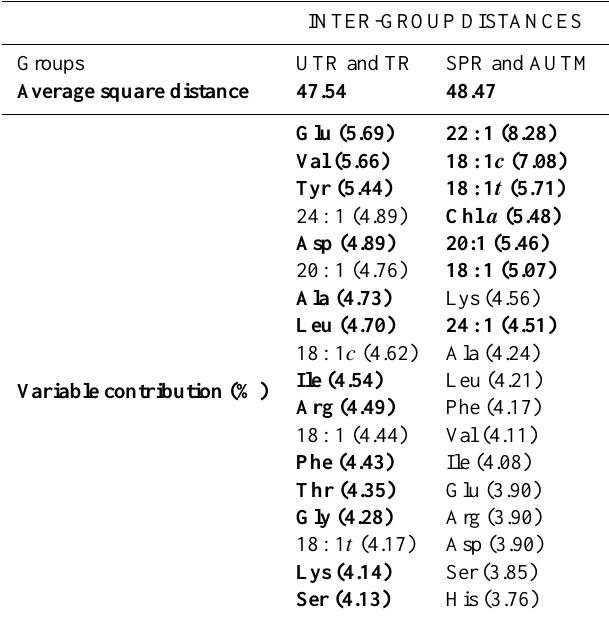
Table 4b. Inter-group distances between UTR and TR and between SPR and